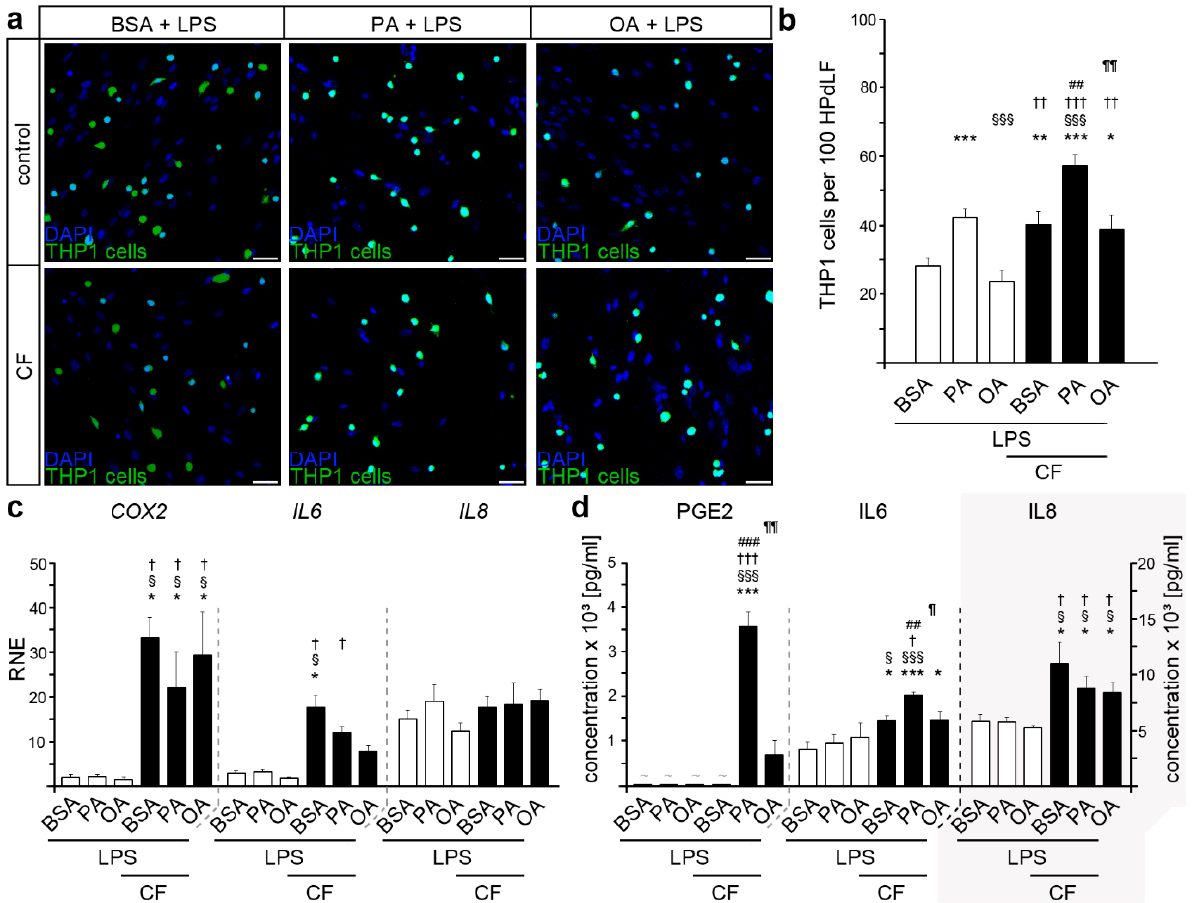
Figure 2. Stimulation with LPS obtained from P. gingivalis led to an excessive immune response in palmitate-cultured HPdLFs undergoing compressive stress. ( a , b ) Analysis of the number of adherent THP1 monocytic cells (green) on HPdLF (blue) stimulated either with palmitic or oleic acid in comparison to BSA controls and stimulated for six hours with compressive force (CF) ( a ). THP1 cells were stained with CellTracker™ and the nuclei of all cells were stained with DAPI. The relative number of THP1 cells is displayed per 100 HPdLF ( b ). ( c ) Quantitative expression analysis of genes coding for inflammatory markers IL6 , IL8, and COX2 in fatty acid-cultured HPdLF stimulated with 6 h compressive force in comparison to BSA controls. Results are normalized to unstimulated BSA controls. ( d ) Analysis of secreted cytokines PGE2, IL6, and IL8 in HPdLF stimulated with palmitic or oleic acid and 6 h of compressive force compared to BSA controls. * p < 0.05; ** p < 0.01; *** p < 0.001 in relation to BSA, § p < 0.05; §§§ p < 0.001 in relation to PA, † p < 0.05; †† p < 0.01; ††† p < 0.001 in relation to OA, ## p < 0.01; ### p < 0.001 in relation to BSA+CF, ¶ p < 0.05; ¶¶ p < 0.01 in relation to PA + CF; one-way ANOVA and post-hoc test (Tukey). Scale bars: 50 µm in ( a ). BSA, bovine serum albumin; CF, compressive force; LPS, lipopolysaccharides of P. gingivalis ; OA, oleic acid; PA, palmitic acid; RNE, relative normalized expression; ~, below detection limit.